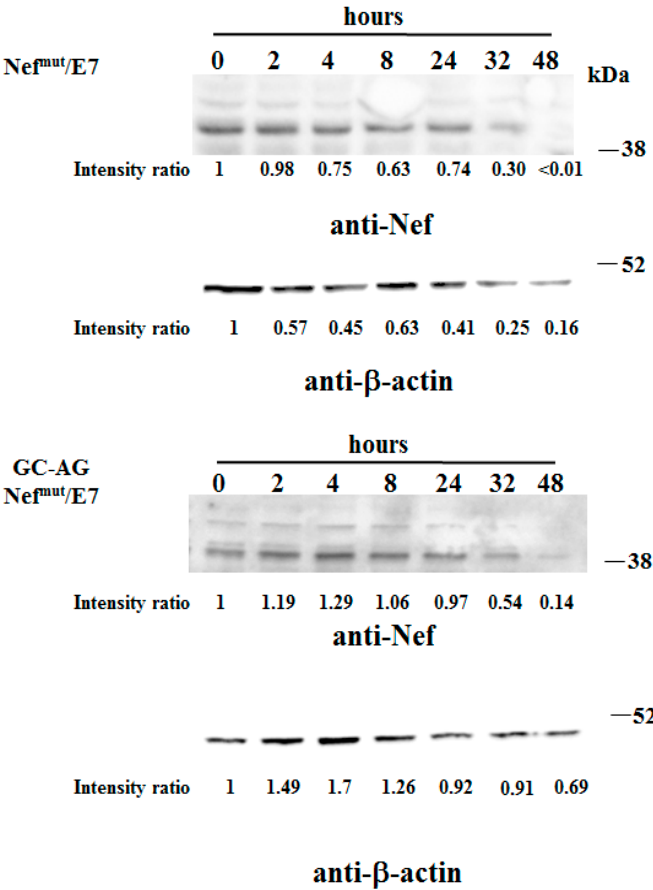
Figure 4. Analysis of stability of GC-AG Nef mut / E7. Comparative stability analysis between Nef mut / E7 and GC-AG Nef mut / E7 fusion proteins in total lysates from HEK-293T cells transfected with the respective DNA vectors. Forty-eight hours after transfection, cells were washed and reseeded in complete medium containing 1 μ g/mL of cycloheximide. Transfected cells were harvested at the indicated times, and total lysates from the same number of cells were analyzed by Western blot assay. Filters were revealed by both anti-Nef and anti- β -actin polyclonal antibodies. Time zero refers to cells harvested at the time of cycloheximide treatment. Signal intensity ratios compared to respectve time zero are indicated. Molecular markers are given in kDa. The results are representative of two independent experiments. Uncropped blots showing all the bands with all molecular weight markers are shown in Supplementary Figure S2.